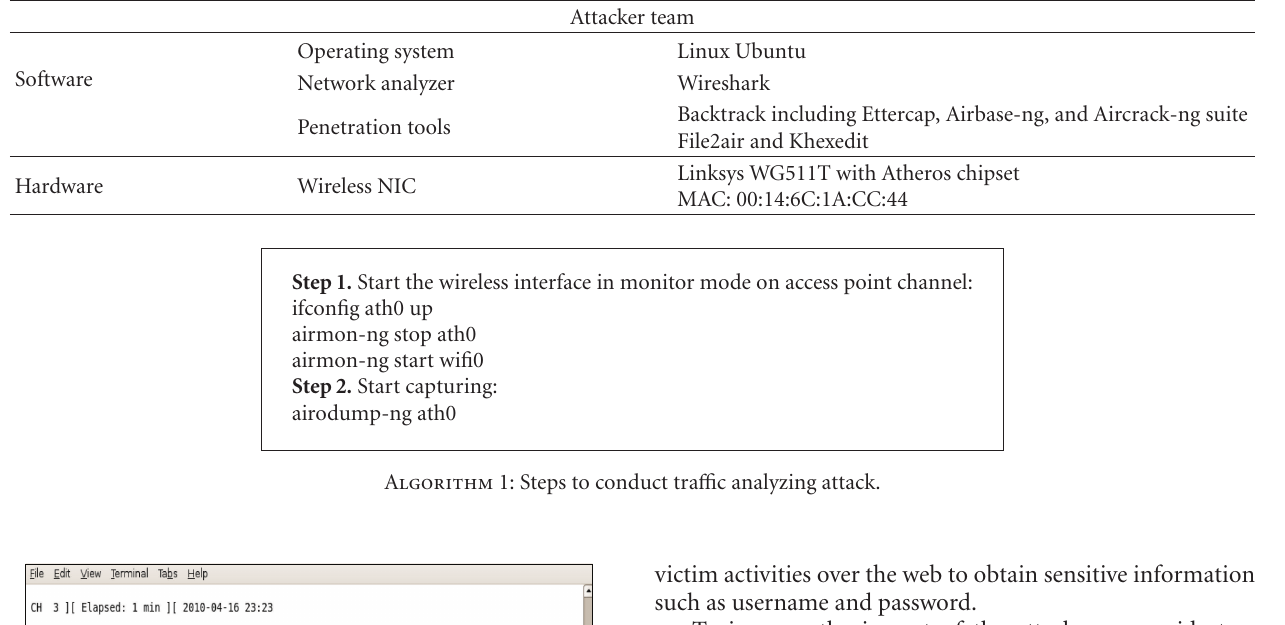
Table 2: Specification of the attacker’s team station.